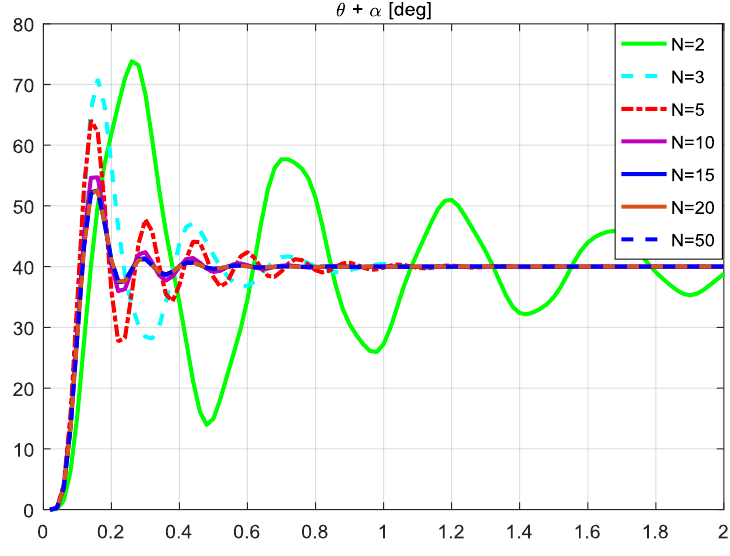
Figure 5. Time response of the unconstrained system with different horizons and 𝚫𝒕 = 𝟐𝟎 𝒎𝒔 .